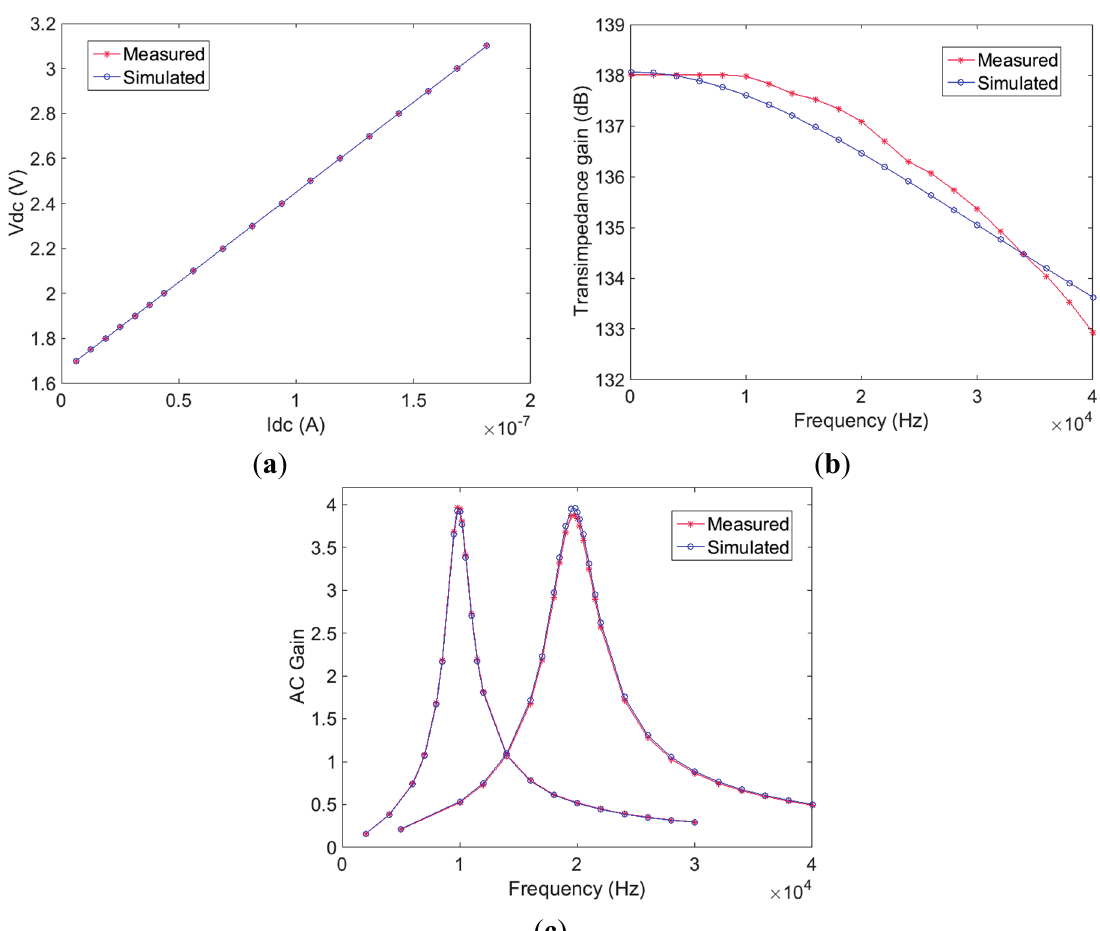
Figure 4. Experimental and simulated chip characterization results ( a ) DC response of the I/V converter; ( b ) Frequency response of the I/V converter; ( c ) Frequency response of the two band-pass